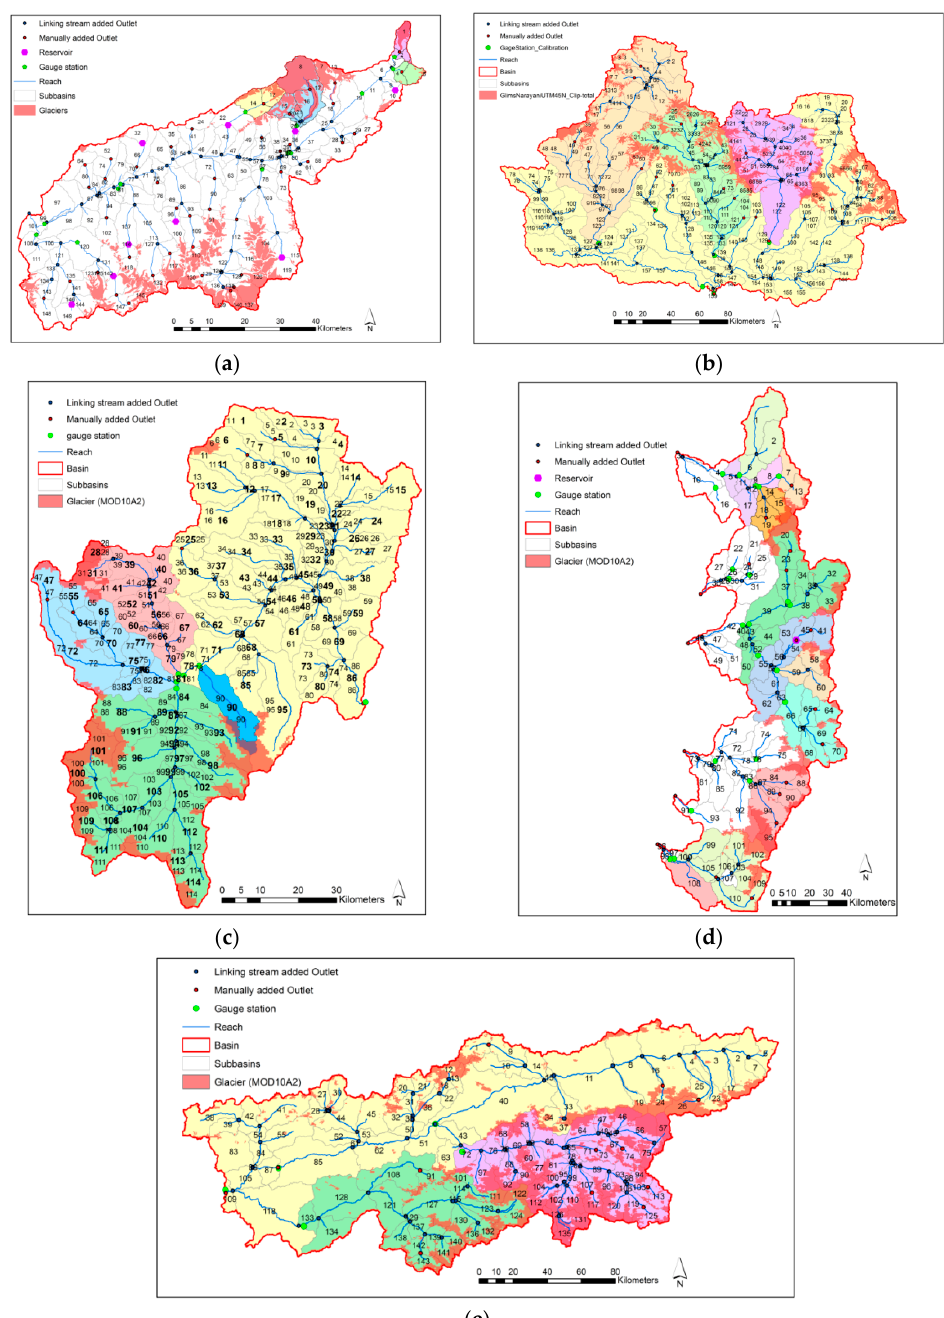
Figure 2. Subbasin delineation, glacier outlines, and locations of dams and flow gauge stations in ( a ) Rhone River Basin; ( b ) Narayani River Basin; ( c ) Chilean River Basins; ( d ) Mendoza River Basin; and ( e ) Vakhsh River Basin.